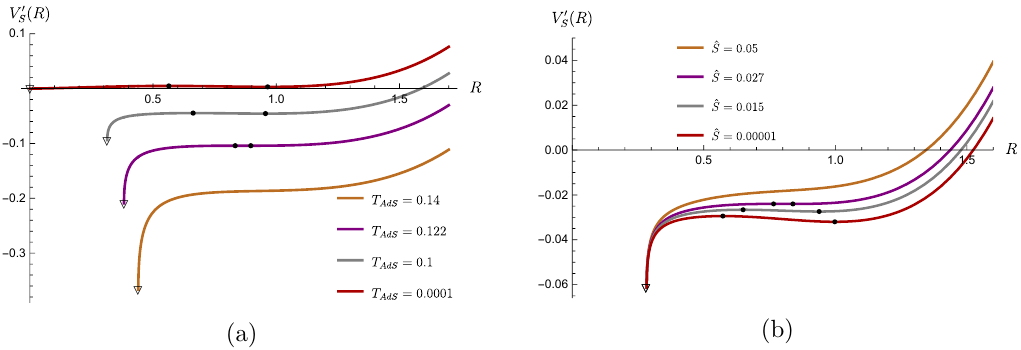
Figure 2. Effective potential using the same choice of parameters and conventions as in figure 1(a), for fixed entropy ˆ S = 0 . 01 (left panel) and for fixed temperature T AdS = 0 . 09 . The purple curve captures the potential felt by the brane close to criticality. The triangle O keeps track of the global minimum at the horizon of the background black